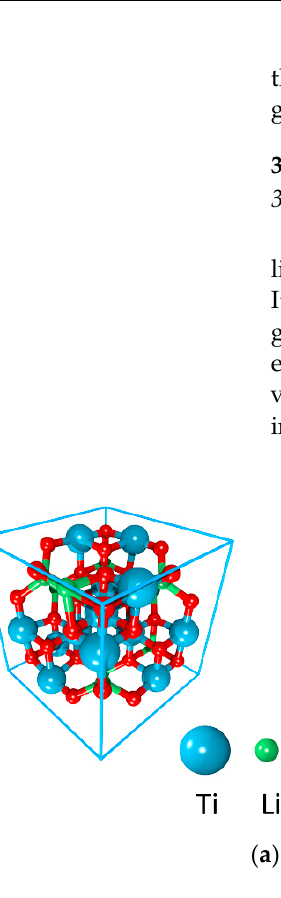
Figure 1. Three-dimensional Li 4 Ti 5 O 12 : ( a ) the unit cell and the bulk structure; ( b ) DOS and pDOS without adding the Hubbard parameter ( left ) and with its addition ( right ).